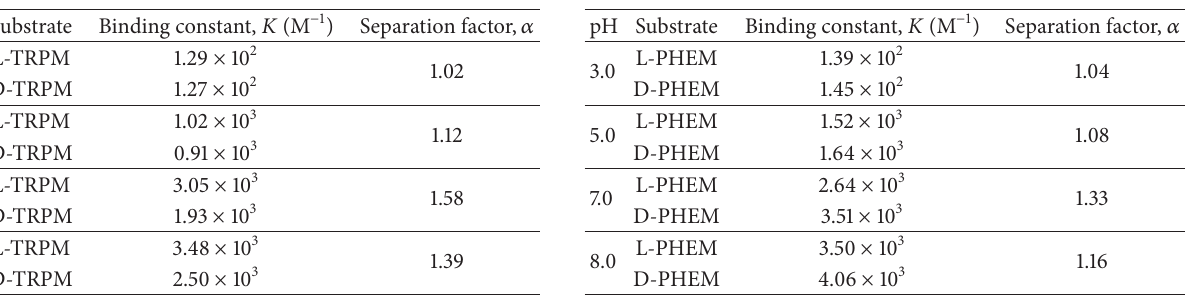
Table 1: The adsorption of L-TRPM and D-TRPM on the L-TRPM- imprinted polymer.